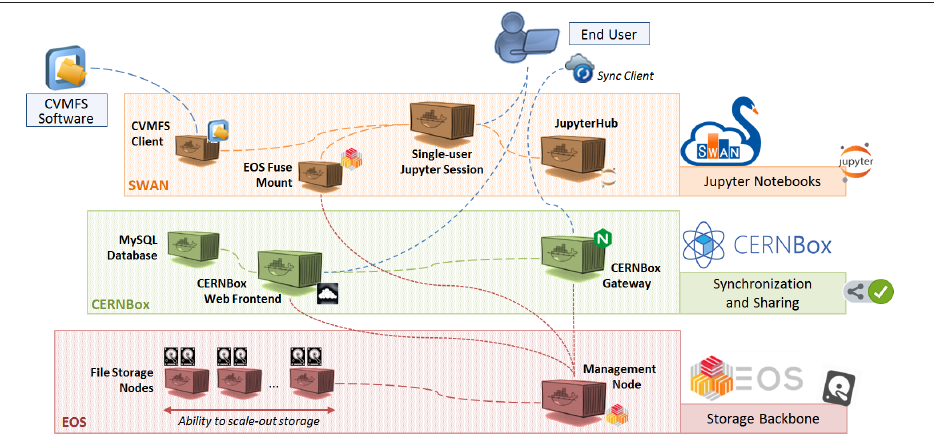
Figure 1. ScienceBox Architecture. EOS, CERNBox, and SWAN are shown as decoupled blocks with tight interactions to provide end users with a fully-fledged working environment. CVMFS delivers the software required by SWAN. Web frontends of CERNBox and SWAN are directly accessible by end users, while a sync client can be configured to use ScienceBox as the remote server for synchronization.